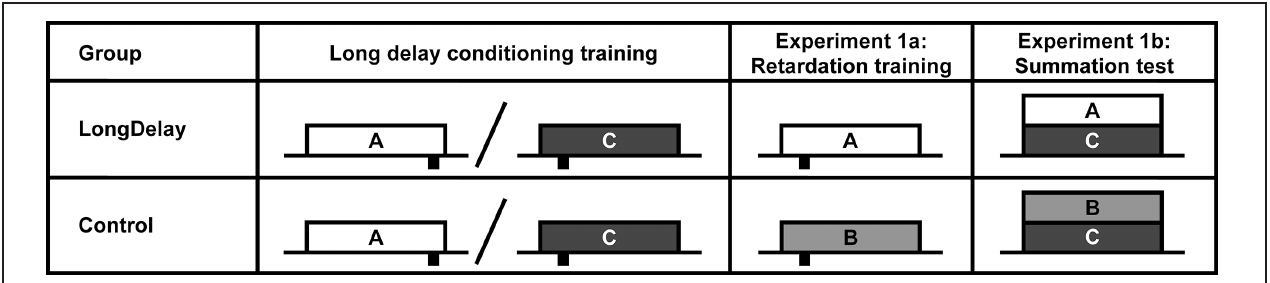
FIGURE 1 | Design of Experiments 1a and b. The white, light gray, and dark gray rectangles represent CSs A, B, and C, respectively. CSs A and B were a 60-s white noise or a 60-s flashing light, counterbalanced within groups. CS C was a 60-s 2,900-Hz tone. Sucrose pellet USs (represented by black rectangles under the time line) were delivered at either 55 or 10 s after CS onset (represented at the appropriate location under the time). Onset of CSs A and C (Group LongDelay) and B and C (Group Control) during summation testing (Experiment 1b) were simultaneous. Slashes represent intermixed presentation of CSs during training. See text for